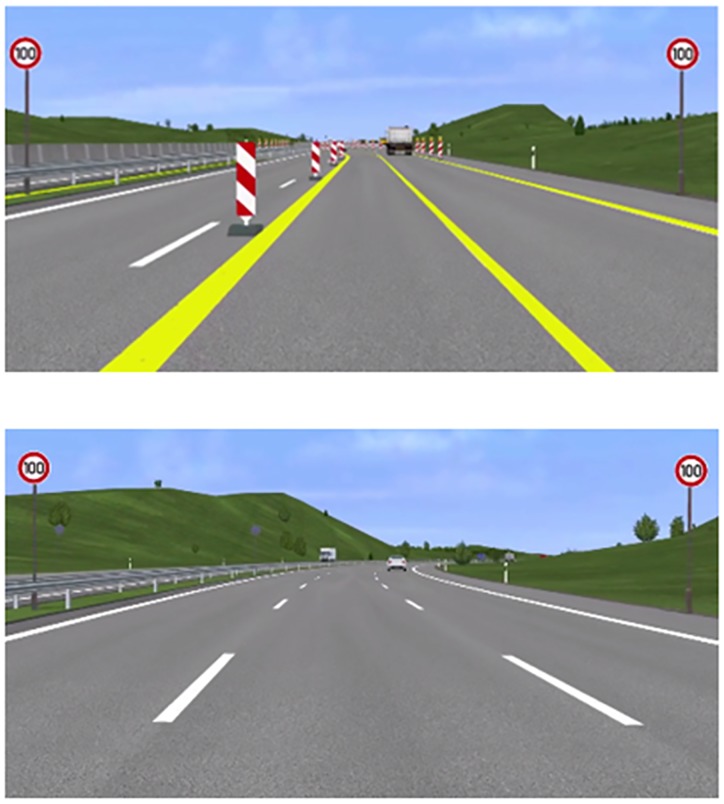
Screenshots from the experimental paradigm. Top: a scene from the construction condition with two lanes of reduced width. Bottom: a scene from the non-construction condition with three lanes and normal lane width.